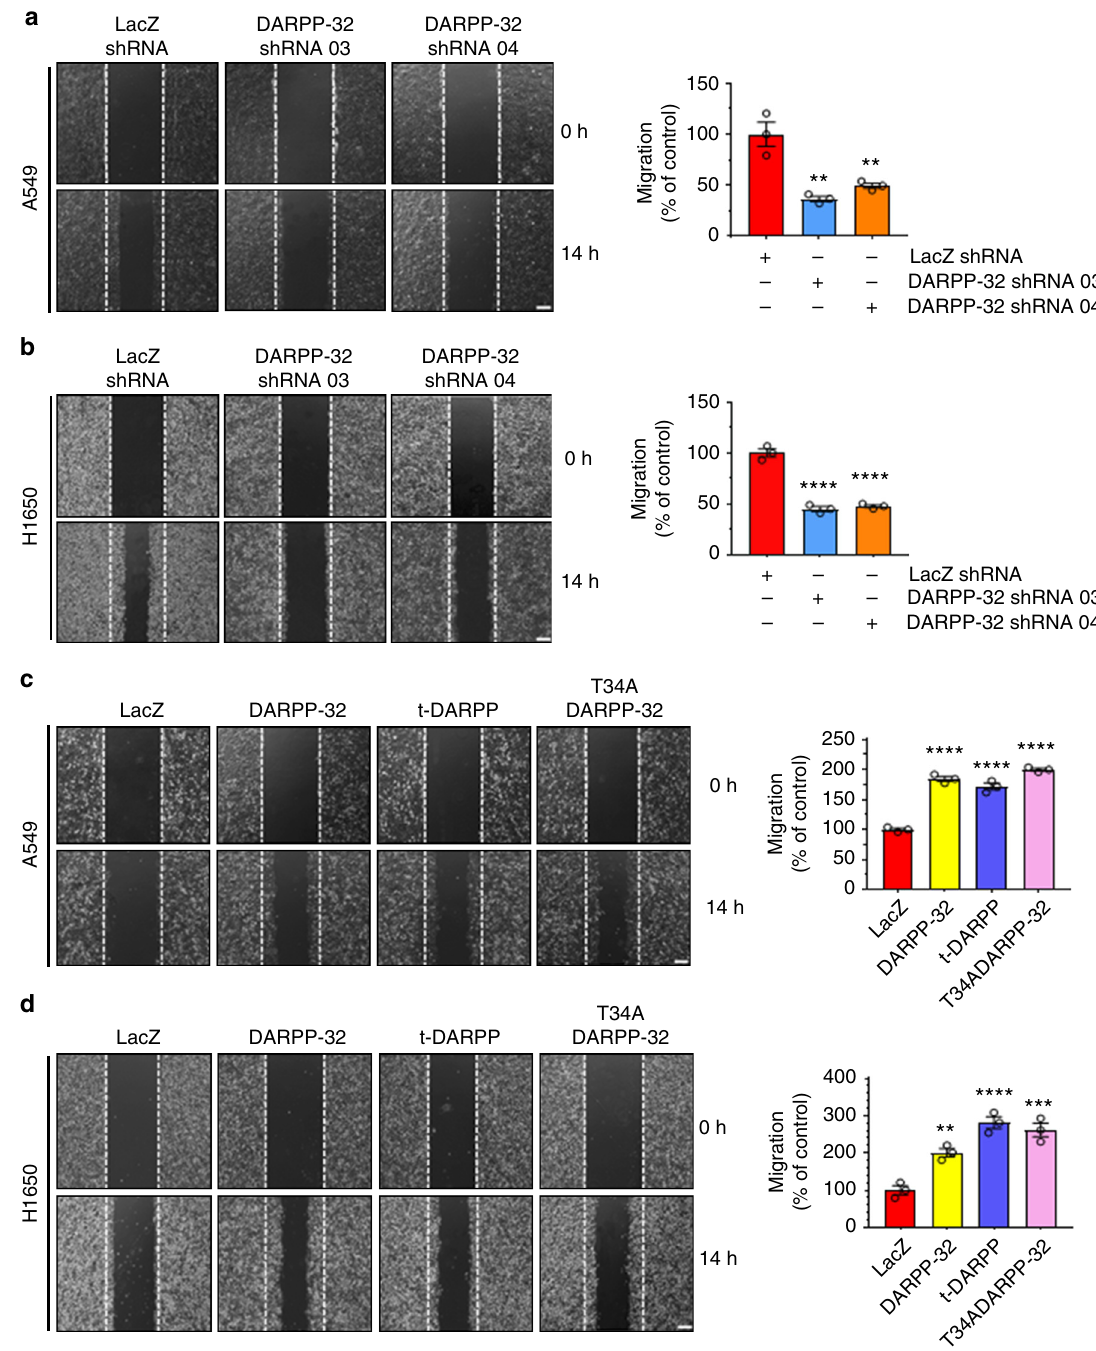
Fig. 3 DARPP-32 positively regulates cell migration. a A549 and b H1650 cells transduced with lentivirus encoding control or DARPP-32 shRNAs were plated into 60 mm cell culture dishes, scratched and imaged at 0 and 14 h. c A549 and d H1650 cells infected with retrovirus encoding control, DARPP-32, t-DARPP or T34A DARPP-32 clones were scratched and imaged at 0 and 14 h. Dashed lines indicate the boundary of the edges of the wound at 0 h. Experiments were repeated at least three times in triplicate. Scale bar, 200 µ m. Distance traveled by the migratory cells were calculated using ImageJ software. Each open circle on a graph represents an independent experiment. Results represent mean ± SEM ( n = 3). ** P < 0.01, *** P < 0.001 and **** P < 0.0001, one-way ANOVA followed by Dunnett ’ s test for multiple control shRNA (Fig. 5a). Next, we examined migration in A549 documented role in cell motility 45 . To con fi rm the role of IKK α in and H1650 cells upon shRNA-mediated NF- ĸ B2 knockdown the non-canonical NF- ĸ B2-mediated regulation of tumor cell (Fig. 5b and Supplementary Fig. 8c, d). NF- κ B2 depletion migration, we performed the scratch wound healing assay with decreased tumor cell migration in the scratch wound healing control or IKK α -depleted NSCLC cells (Fig. 5a and Supplemen- assay (Fig. 5b), suggesting both IKK α and NF- κ B2 proteins are tary Fig. 8a, b). We observed a substantial decrease in migration potent activators of lung tumor cell migration. Based on our of IKK α shRNA-transduced cells compared to those expressing